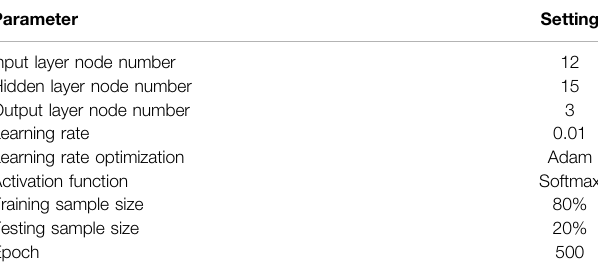
TABLE 9 | Parameter settings for three types of neural networks. Parameter